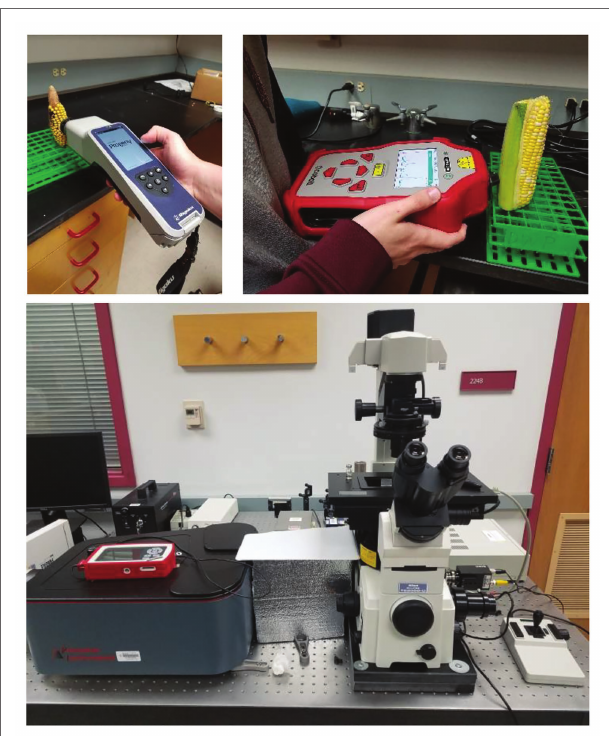
FIGURE 2 | Schematic representation of a Raman